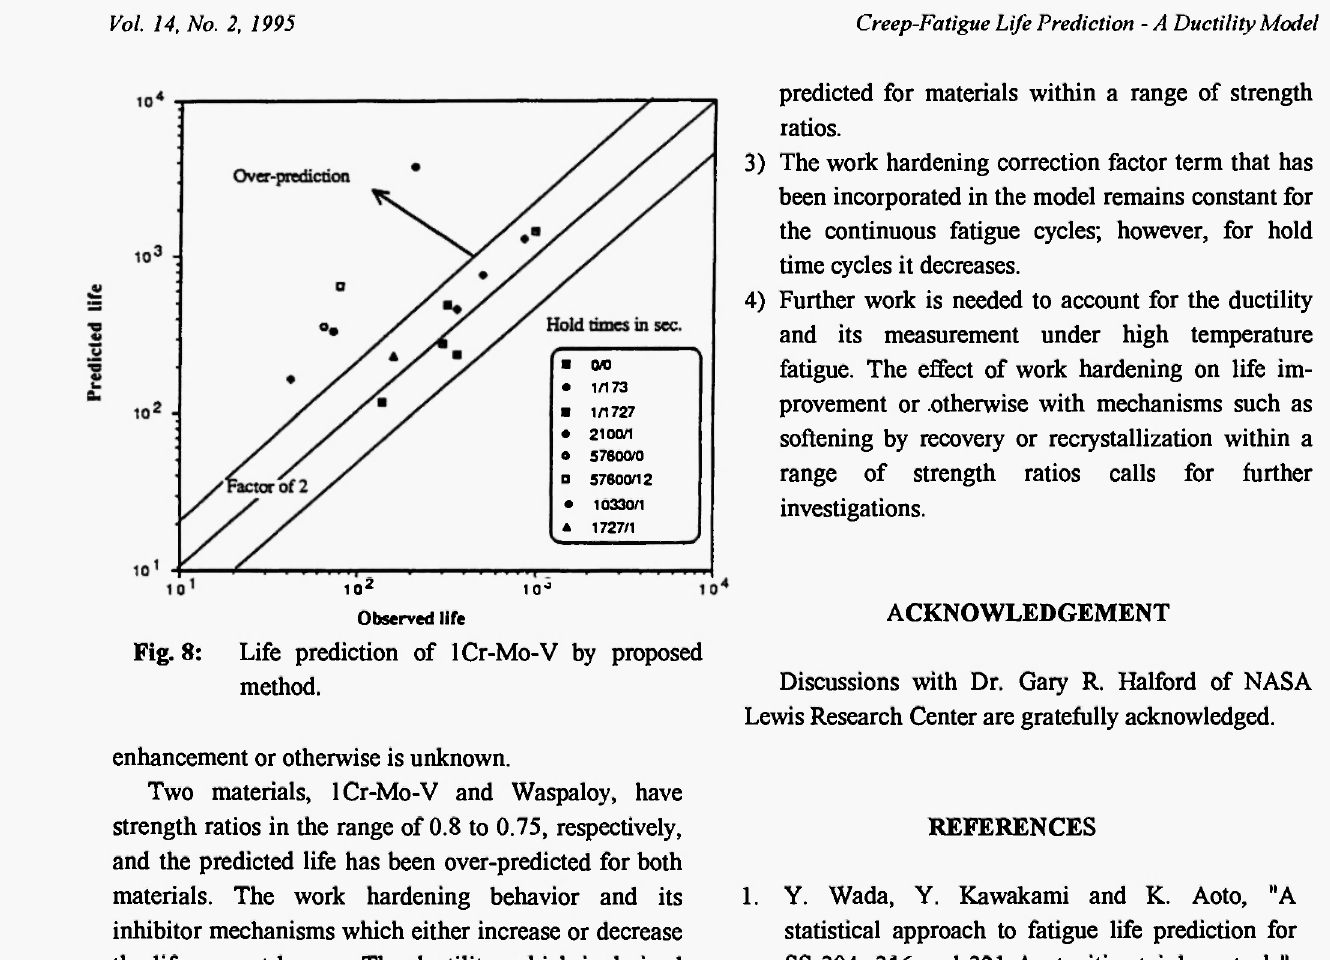
^o 2 io J Observed life Fig. 8: Life prediction of lCr-Mo-V by proposed